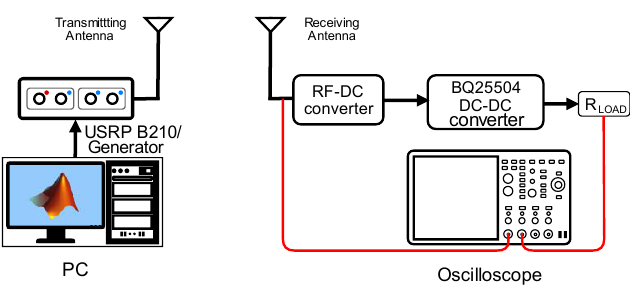
Fig. 5. Test setup for WPT performance measurement using the RF-DC-DC conversion.